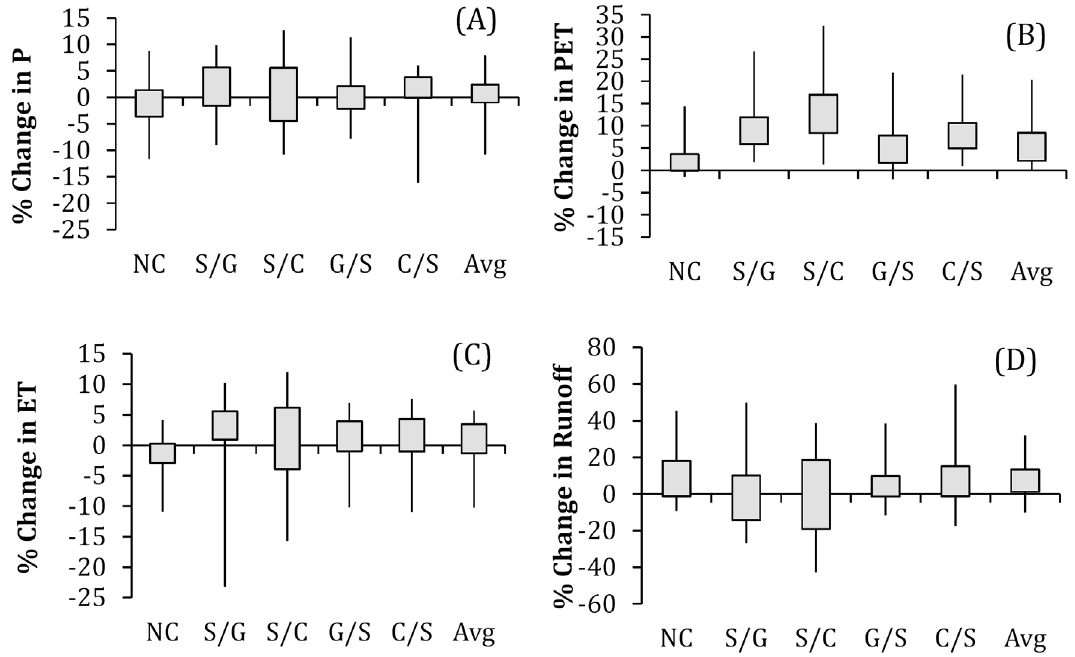
Figure 4. Percent difference in (A) annual precipitation; (B) PET averaged by land use categories in switchgrass altered regions in Kansas and Oklahoma as shown in Figure 1. Box top and bottom edges are the interquartile range of percent difference for each year, and whiskers are maximum and minimum annual values. X-axis labels are land use categories: No Change (NC), Switchgrass/Grassland (S/G), Switchgrass/ Cropland (S/C), Grassland/Switchgrass (G/S), Cropland/Switchgrass (C/S), and average over all categories (Avg).